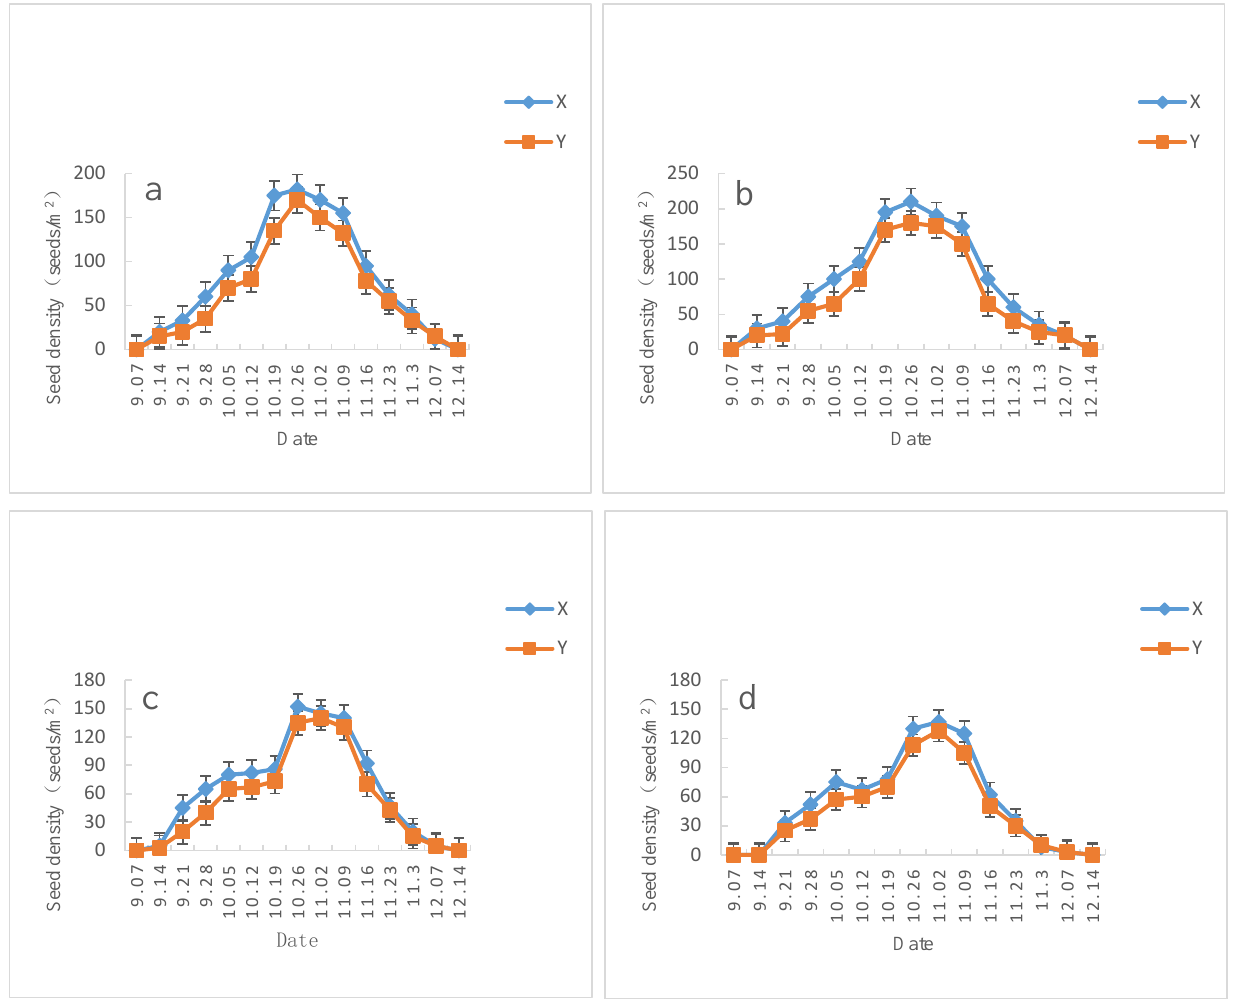
Figure 3. ( a ) semi-sunny slope; ( b ) sunny slope; ( c ) semi-shady slope; ( d ) shady slope. Castanopsis hystrix seed distribution of two types of seed collectors on different slope directions. (X) On-ground seed collector (blue); (Y) off-ground seed collector (orange). Table 4. Seed vigor and temporal dynamics of the Castanopsis hystrix soil seed bank on different slope directions. Slope Direction